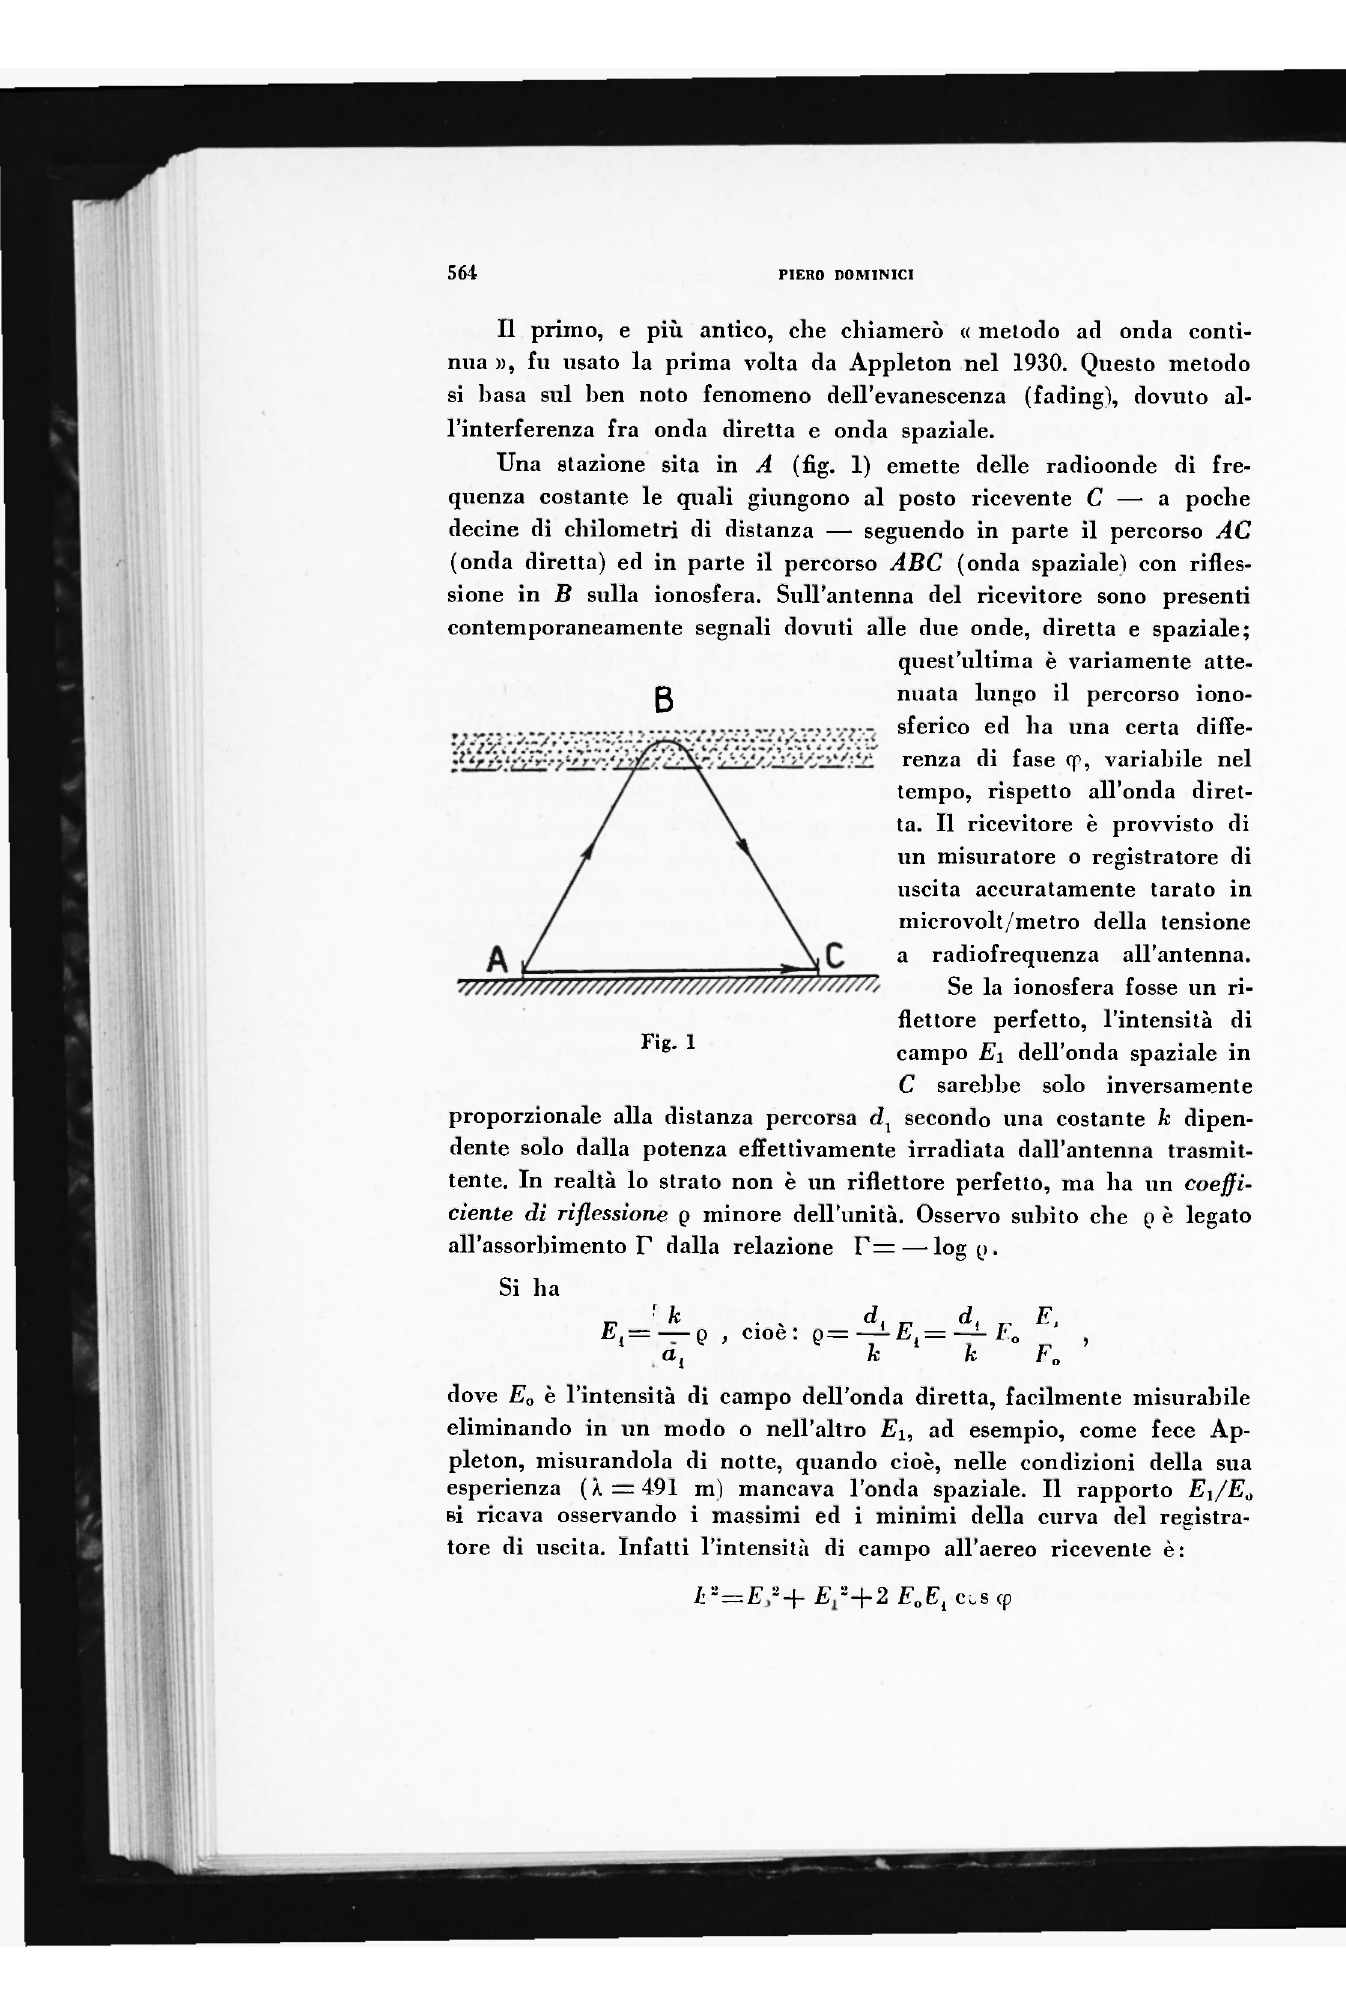
renza di fase <p, variabile nel tempo, rispetto all'onda